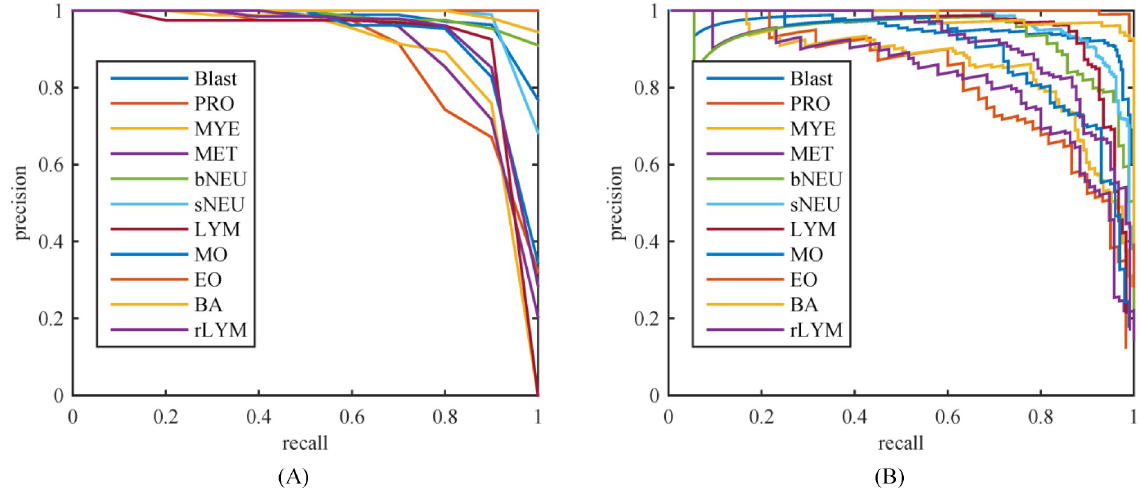
Fig 8. Precision versus recall. (A) SSD300 × 300_Smin = 0.2 with a mAP of 0.931; (B) YOLOv3_320 × 320 with a mAP of